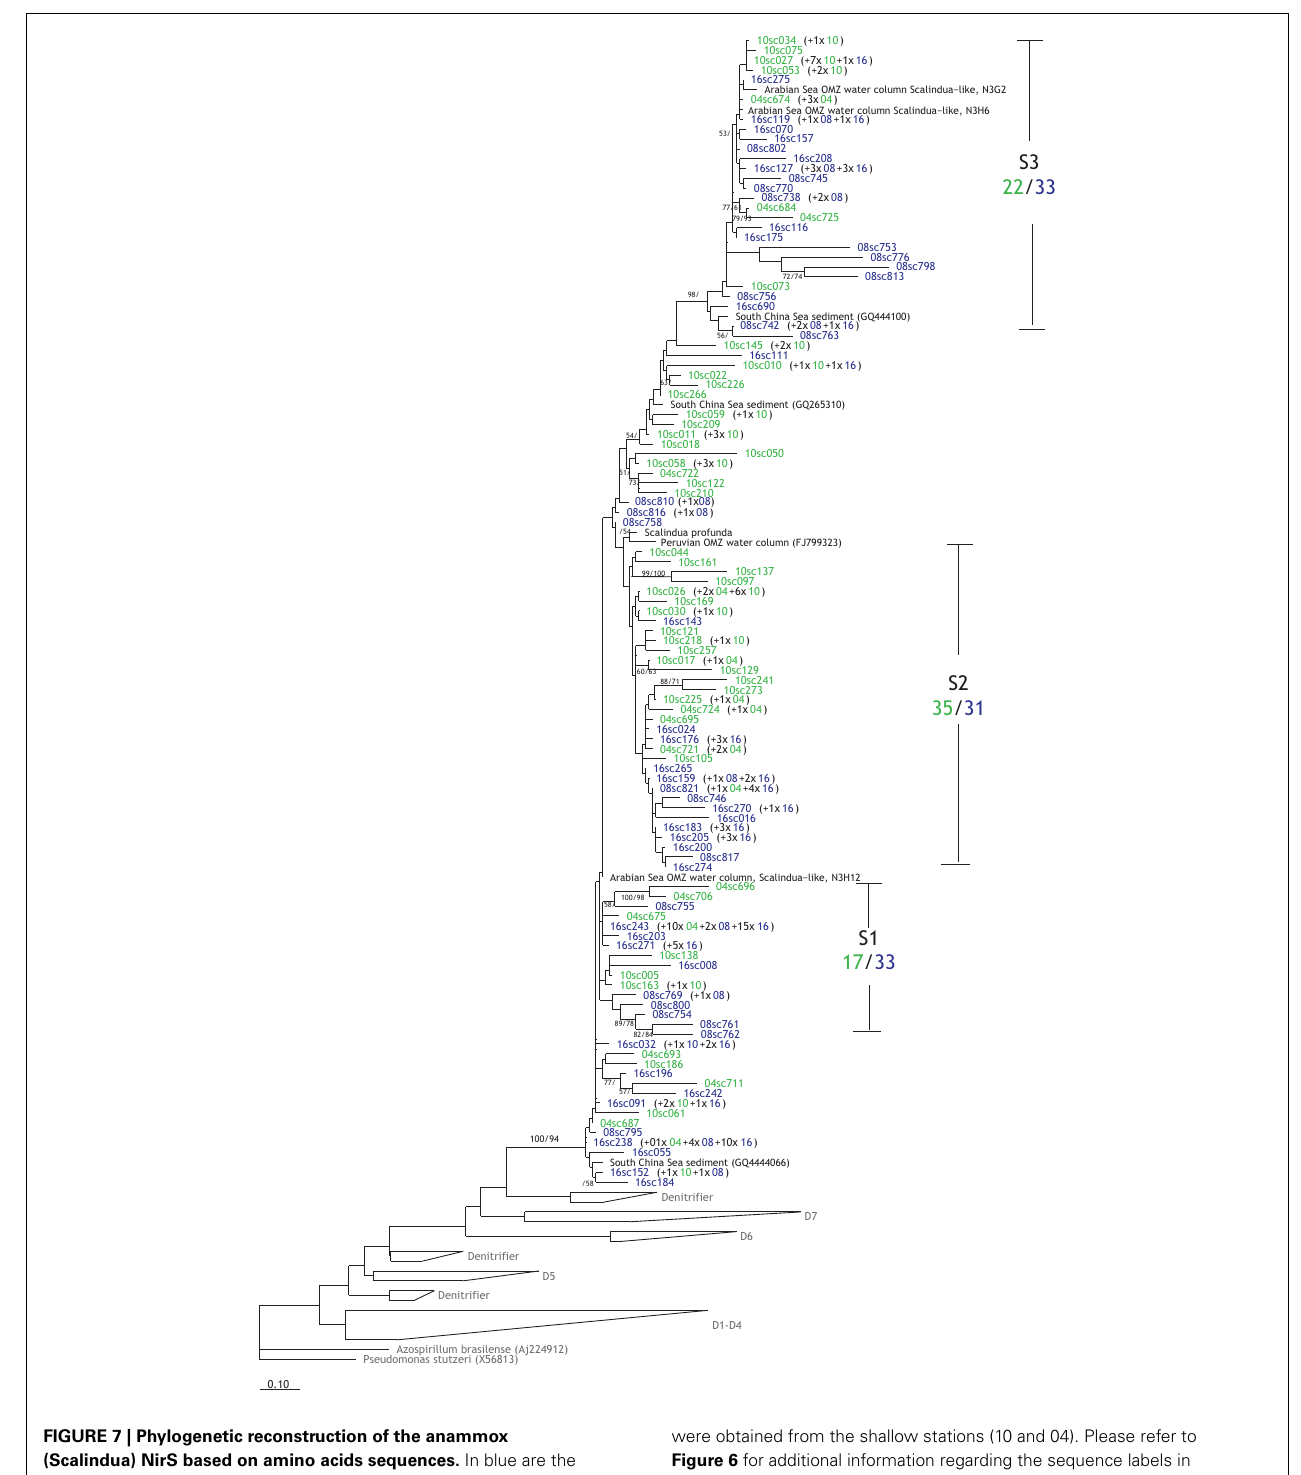
FIGURE 7 | Phylogenetic reconstruction of the anammox (Scalindua) NirS based on amino acids sequences. In blue are the OTUs from the deep stations (08 and 16), while the green sequences